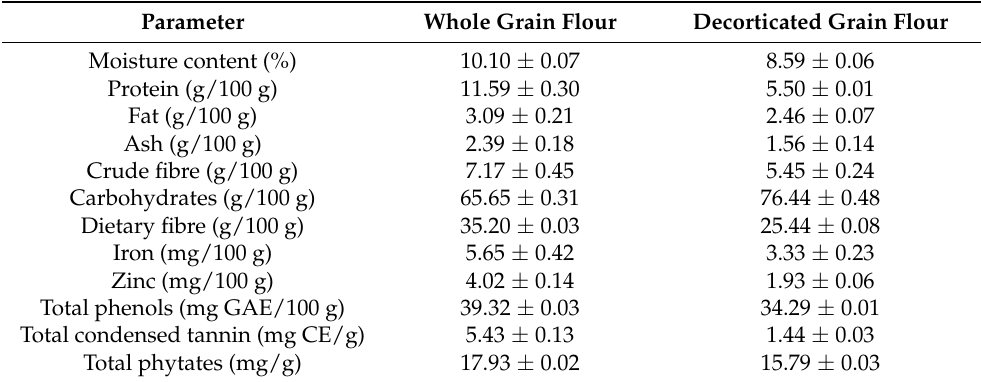
Table 2. Proximate composition, mineral content, total phenols, and antinutrient content of sorghum flour obtained from whole unpolished and conventionally decorticated grains to show the loss of macro- and